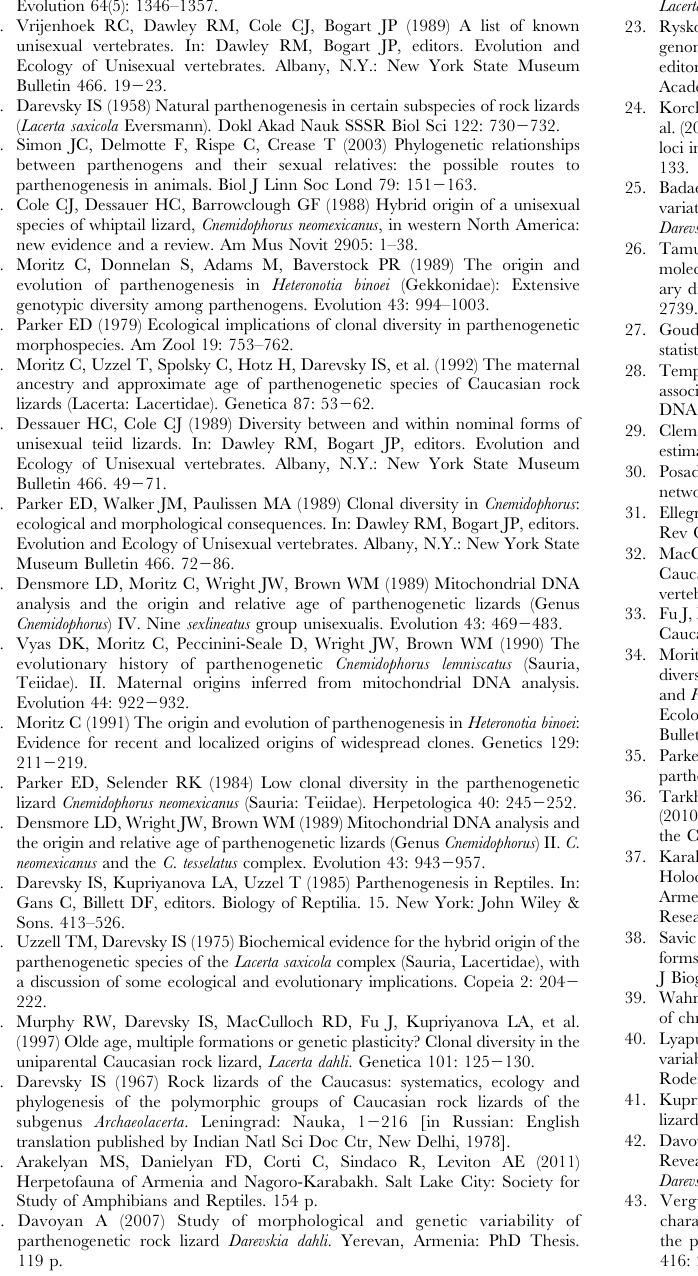
Table S2 The population indices of gene diversity for three studied loci in five sampled populations. N – number of alleles, Rs – allelic richness, H E –